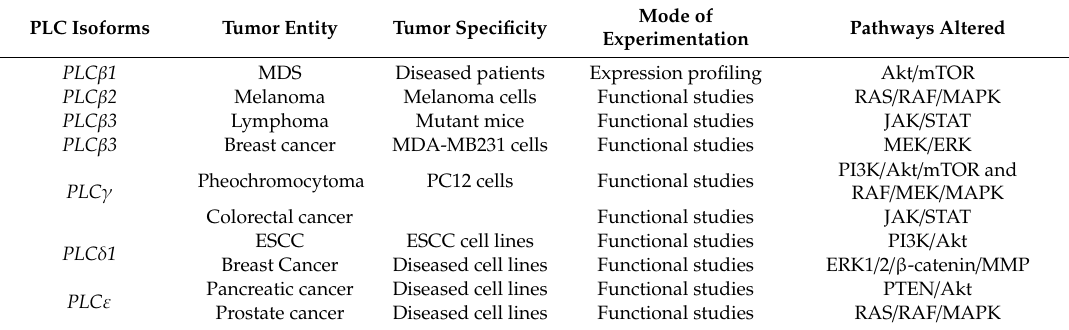
Table 1. Major pathways altered by PLCs in various cancer